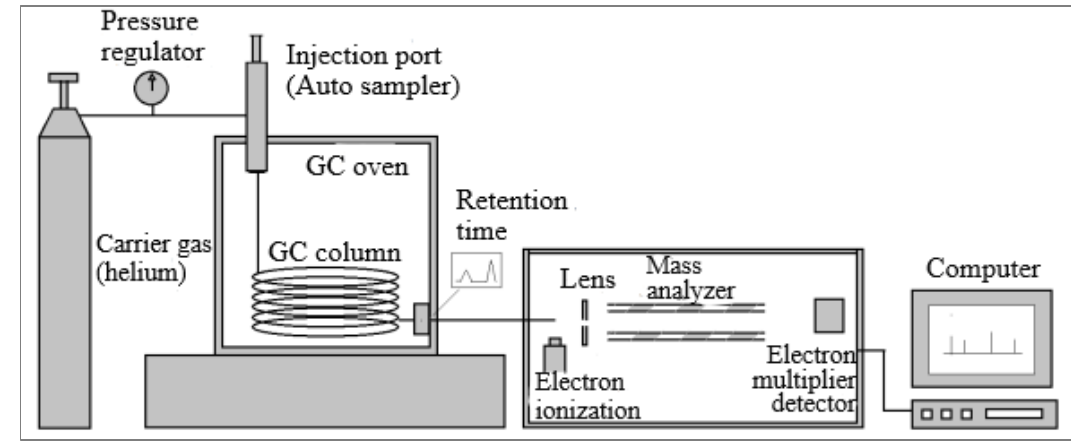
Figure 3. Block diagram of GC-MS setup.